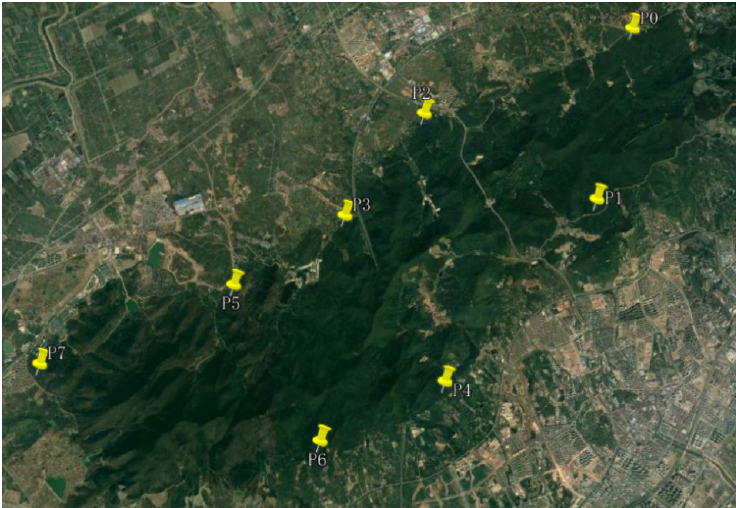
Figure 6. Site distribution of UAVs. Table 6. Longitude and latitude corresponding to UAV